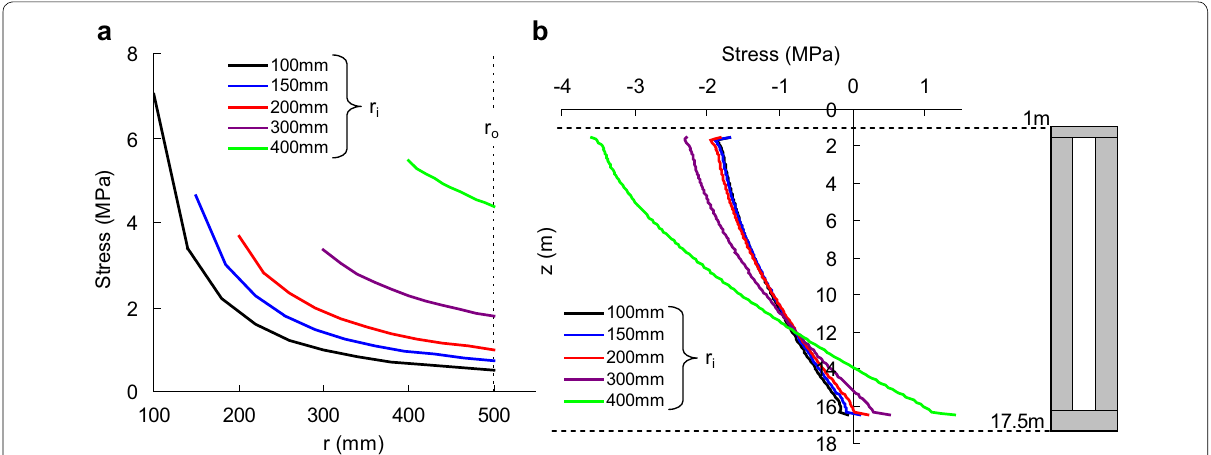
Fig. 12 Stress for the pile section with different inner radius: a circumferential stress; b vertical